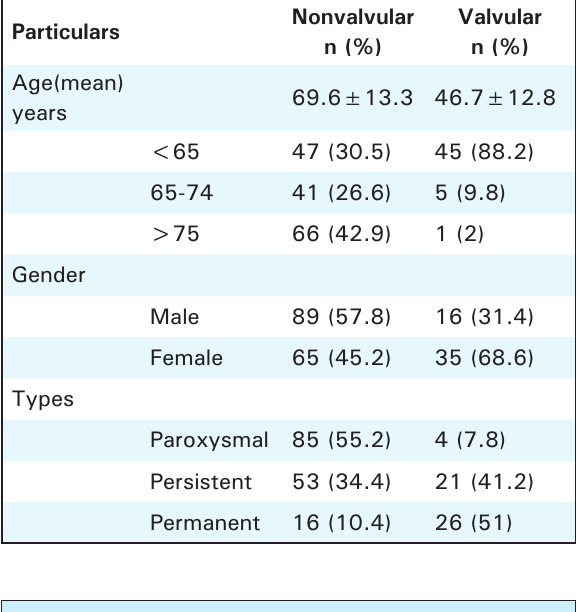
Table 1. Study population of valvular and nonvalvular atrial fibrillation.